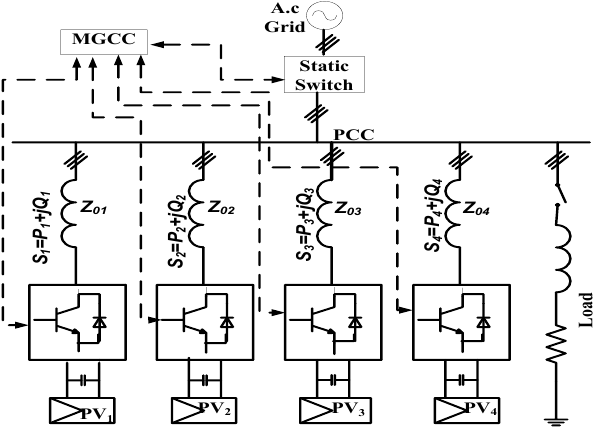
Fig.1. System configuration of a Microgrid having four DGs